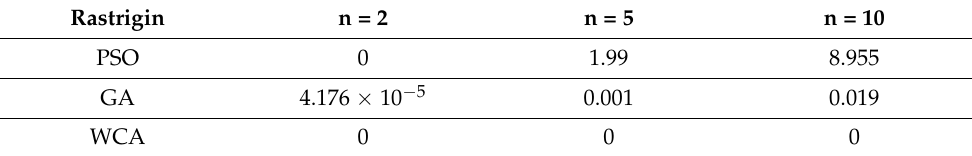
Table 3. The optimal fitness value for Rastrigin function